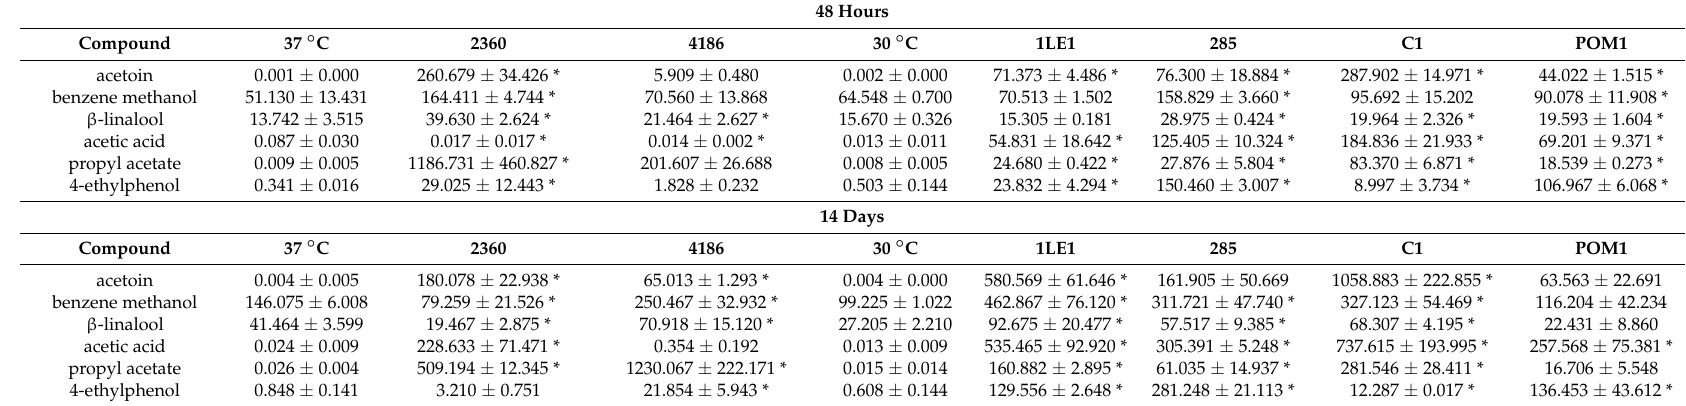
Table 3. Volatile compounds. Volatile compound concentrations (ng/mL) in fermented and unfermented cherry juice.